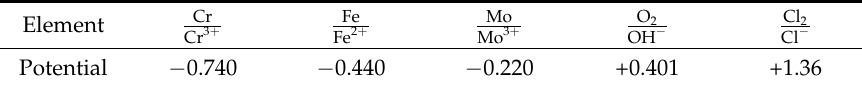
Table 2. Electron potential of element and its